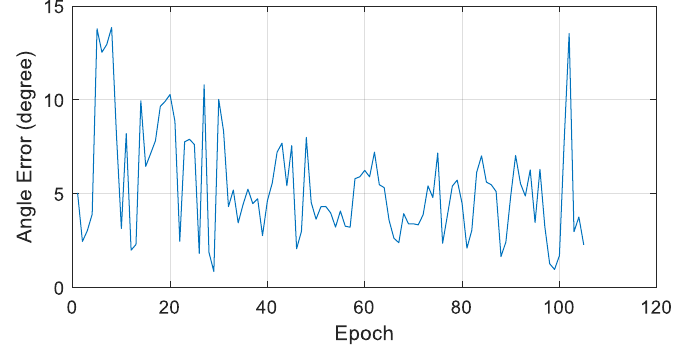
Figure 11. Angle error between two sun-pointing vectors (power generation > 4 W cases).